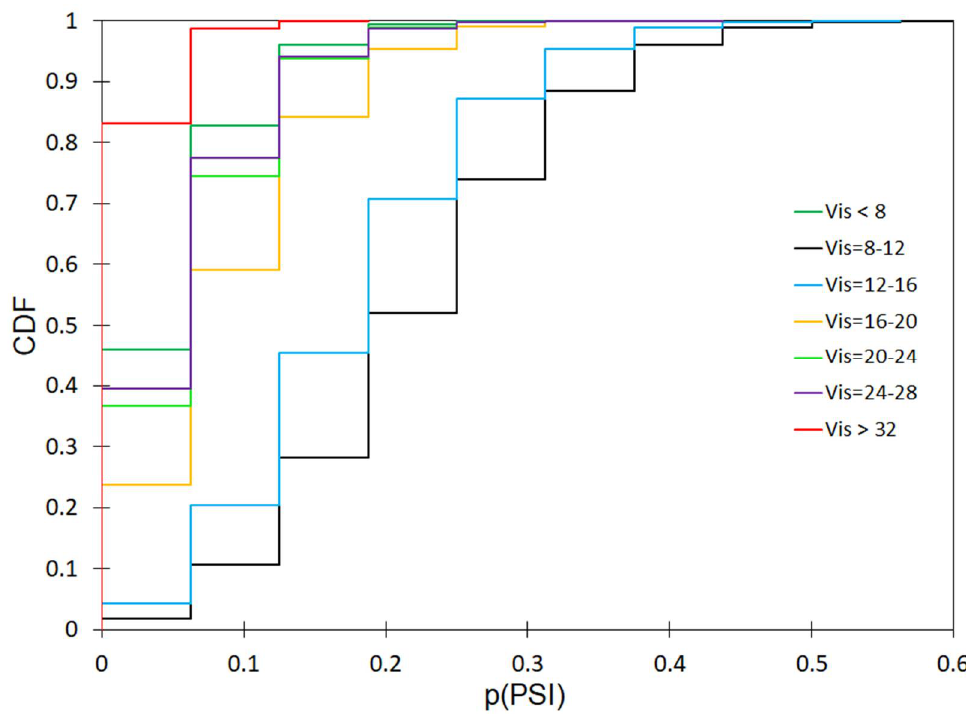
Figure A28. Effect of visibility on incidence of low winter mortality for rainy days.